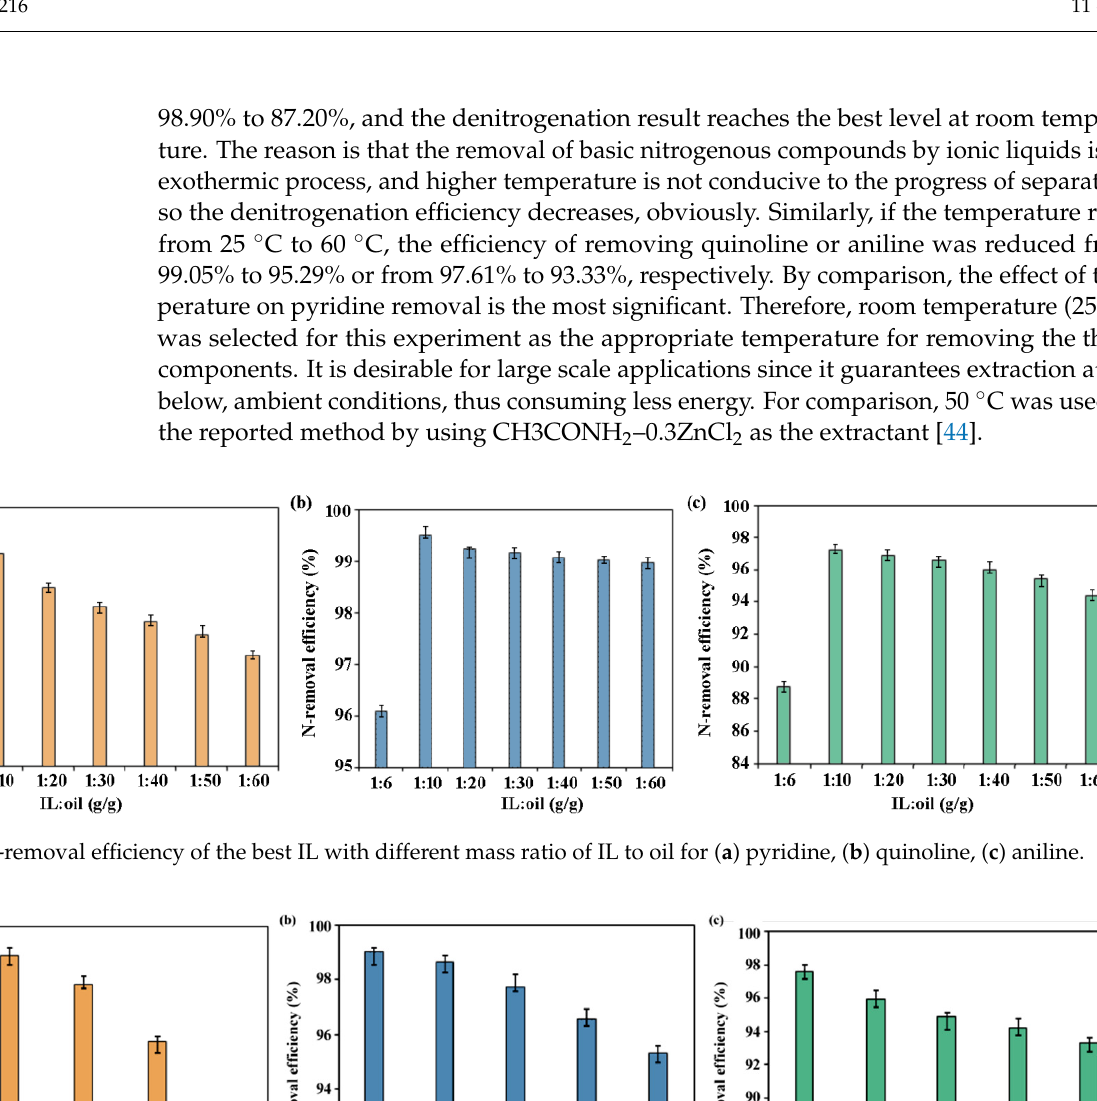
Figure 6. N-removal efficiency of the best IL under different temperatures for ( a ) pyridine, ( b ) quinoline, ( c ) aniline.